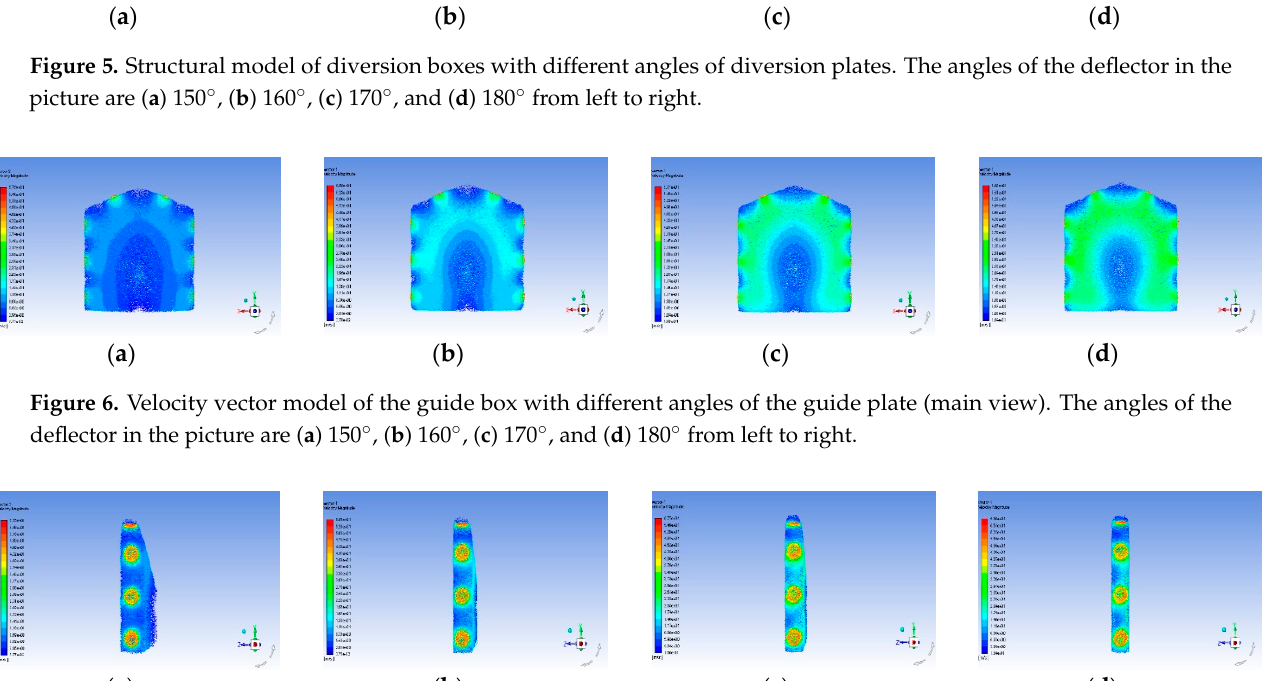
Figure 7. Velocity vector model of the guide box with different angles of the guide plate (left view). The angles of the deflector in the picture are ( a ) 150°, ( b ) 160°, ( c ) 170°, and ( d ) 180° from left to right. Table 4. The simulation results of the maximum wind speed of each air outlet under the condition of different angles of the deflector.